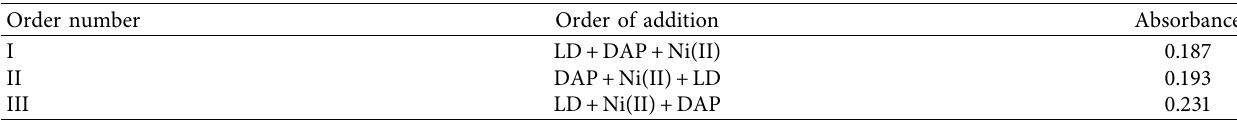
Table 2: Order of